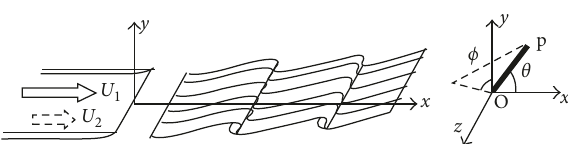
Figure 1: Mixing layer flow and cylindrical